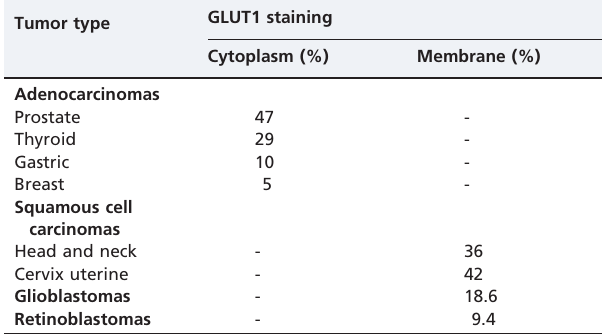
Table 2 - Profile of GLUT1 immunoexpression in tumors according to